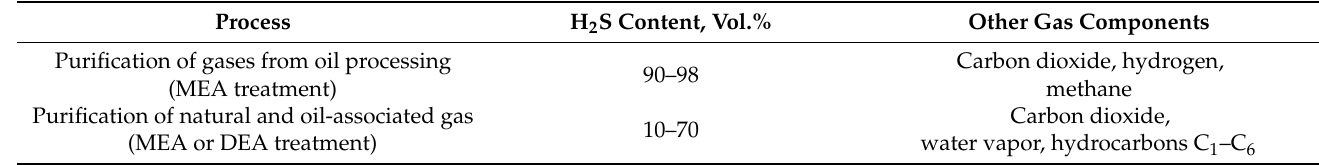
Table 1. Typical characteristics of acid gases of various